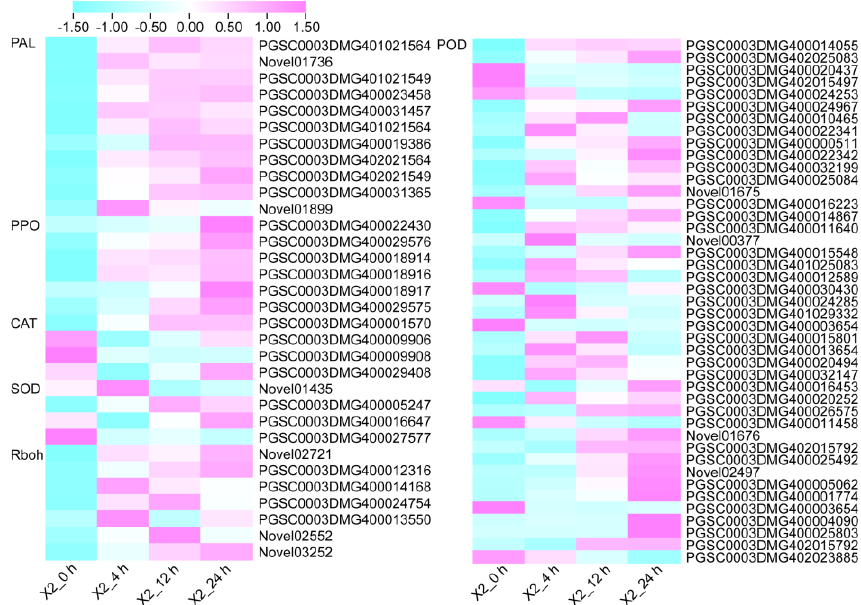
Figure 4. The expression heatmap of antioxidant enzymes − related genes based on the values of FPKM. PAL, Phenylalanine ammonialyase; PPO, polyphenol oxidase; CAT, Catalase; SOD, superoxide dismutase; POD, peroxidase. Table 1. Enrichment of the DEGs with |log2FC| (cid:61) 6 on KEGG pathways.